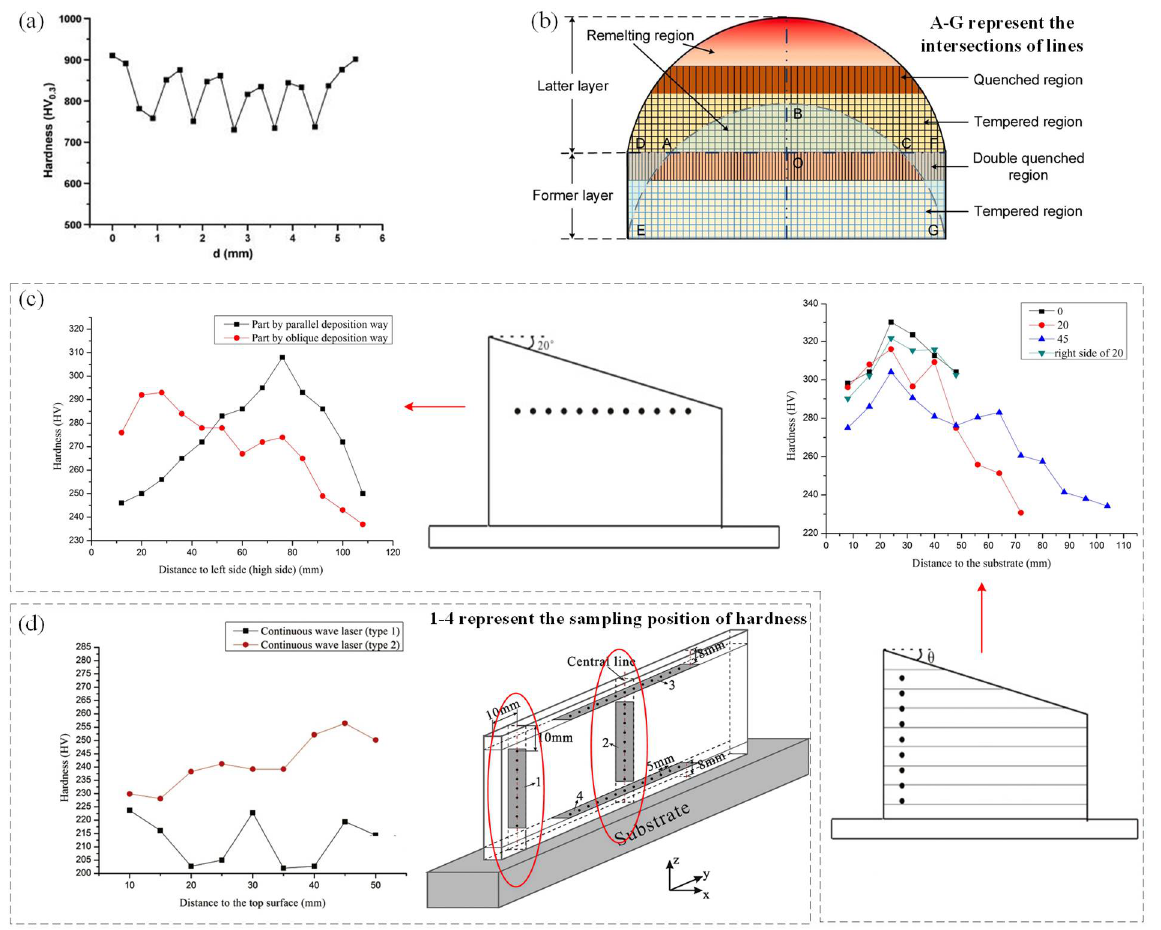
Figure 7. ( a ) Hardness distribution in height-direction of the WC/Ni thin wall sample, (Reprinted from ref. [77], copyright (2009), with permission from Elsevier); ( b ) Schematic illustration of thermal history in laser material deposition process (Reprinted from ref. [26], copyright (2020), with permis- sion from Elsevier); ( c ) Hardness distribution in parallel and vertical direction of the 316L slope thin-wall (Reprinted from ref. [2], copyright (2016), with permission from Elsevier); ( d ) Hardness distribution in the vertical direction of 316L thin wall (Reprinted from ref. [37], copyright (2016), with permission from